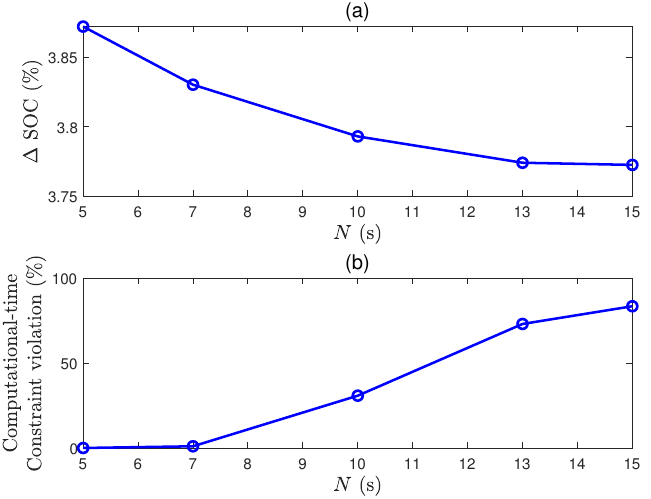
Figure 7. ( a ) Battery SOC reductions with respect to N , and ( b ) computational burdens with respect to N . The computational-time constraint violation represents the ratio between the number of occurrences where t c > T s and the number of samples of the entire